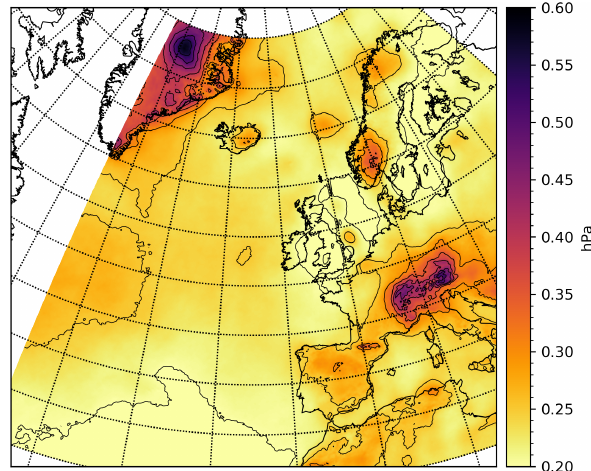
Figure 7. ECMWF-IFS absolute pressure discontinuity (jump) av- eraged over all forecasts during 2016–2018. The spatial average over the neatl area (Fig. 5) is 0.22hPa.